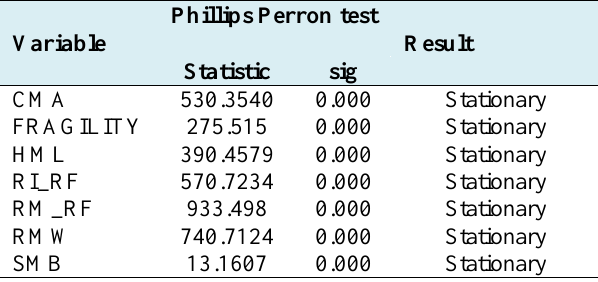
Source: research